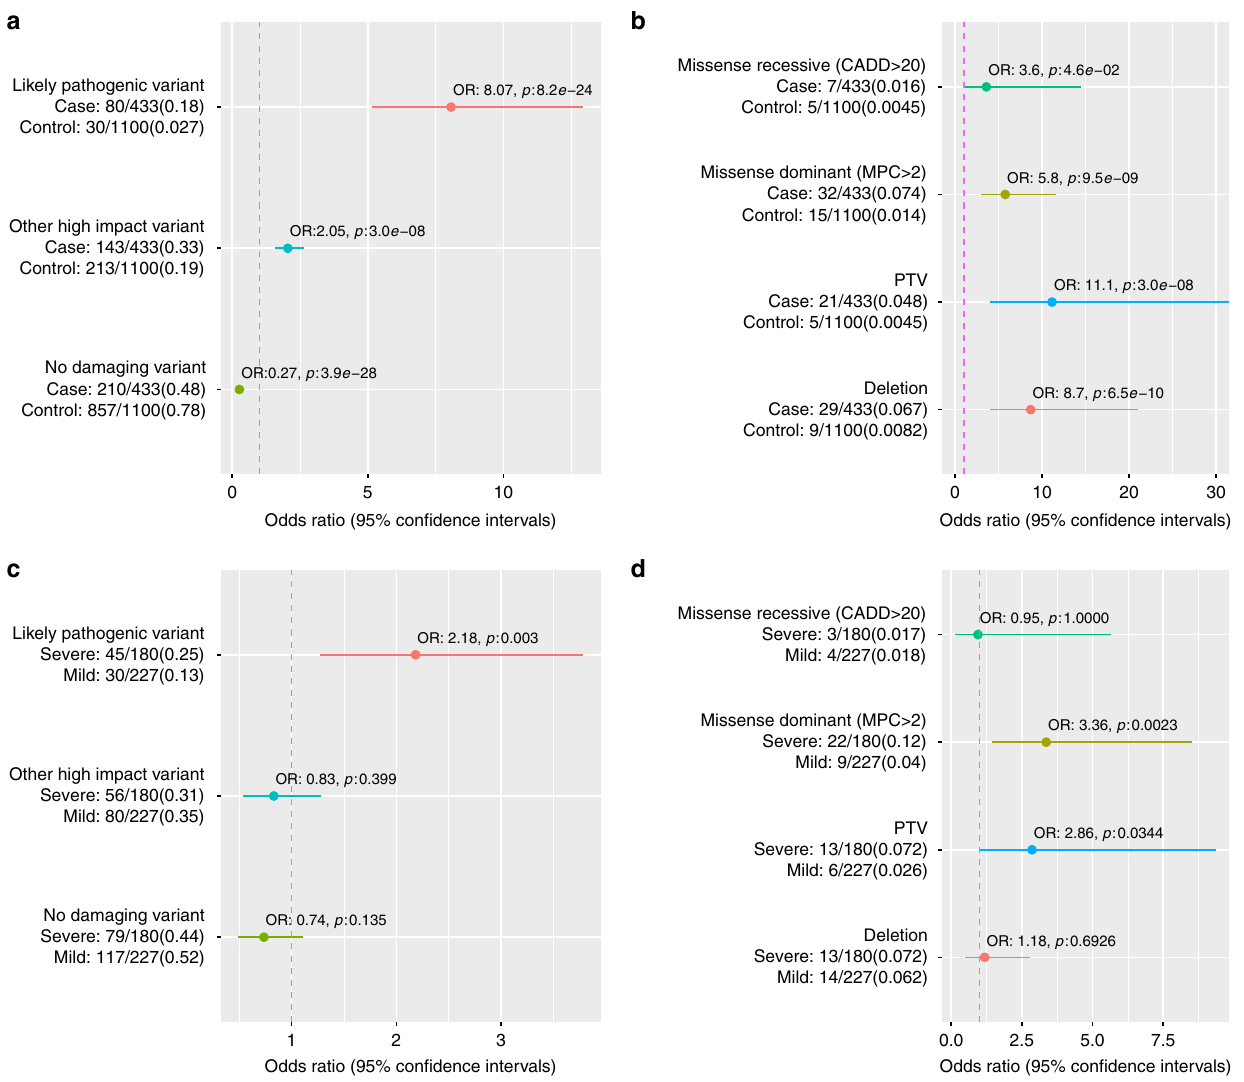
Fig. 5 Comparison of the total rate of different classes of variants. Comparison was performed in cases vs. genetically matched controls and in mild vs. more severe ID individuals for which both exome and CNV data was available. On the left the number of carriers and total individuals are given and in parenthesis the proportion of carriers. Circles indicate odds ratio and lines indicate 95% con fi dence intervals of the odds ratio estimate. a Total genetic diagnostic rate. b Variant classes in “ Likely pathogenic ” variant categories. c Comparison of the rate of identifying different classes of variants in mild vs. severe (moderate and profound ID combined) patients. d Comparison of the rate of variant types in “ Likely pathogenic ” category between mild and more severe forms of ID (moderate, severe and profound ID combined). Constrained missense (MPC > 2) variants were analyzed in all genes instead of only high pLI genes in C and D as MPC score incorporates regional missense constraint. Source data are provided as a Source Data fi